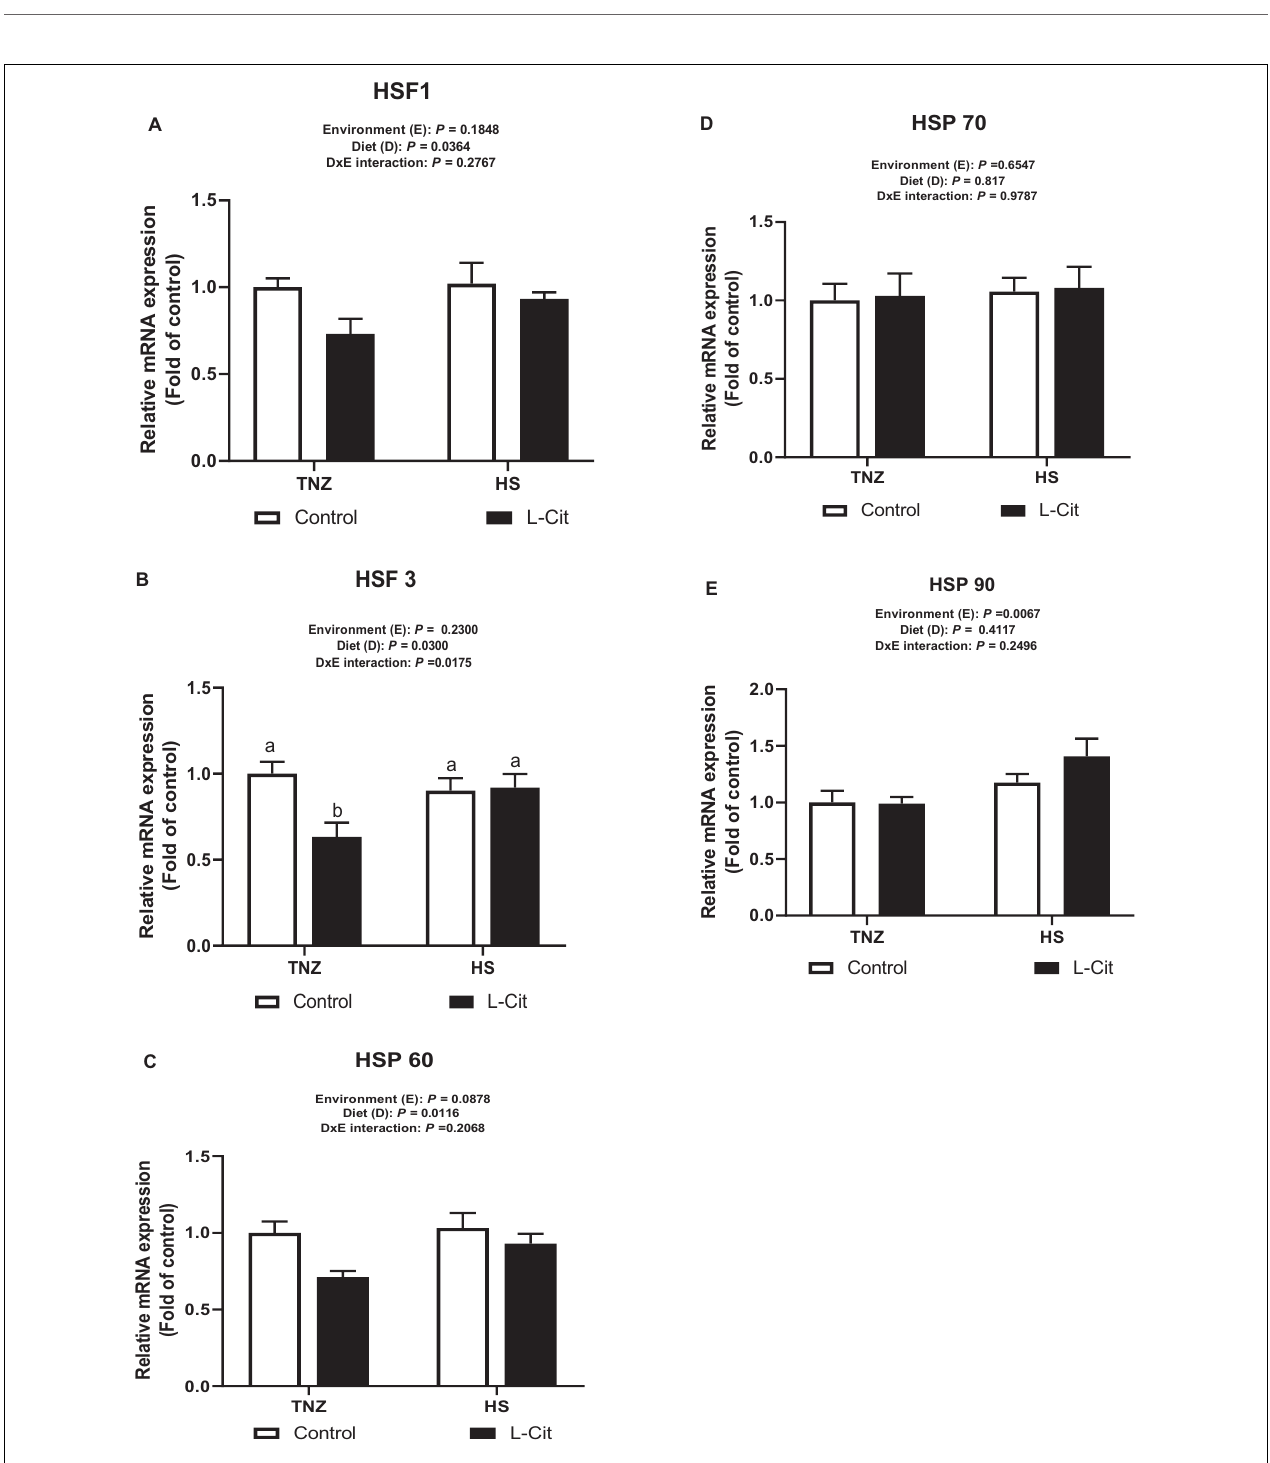
FIGURE 4 | Effect of L -citrulline supplementation on hypothalamic mRNA expression of stress-related genes during acute heat stress. (A) Heat shock factor 1 (HSF1). (B) Heat shock factor 3 (HSF3). (C) Heat shock protein 60 (HSP 60). (D) Heat shock protein 70 (HSP 70). (E) Heat shock protein 90 (HSP 70). Data are presented as mean ± SEM ( n = 8). TNZ, thermoneutral; HS, heat stress. a , b Different letters indicate significant difference of D × E interaction at P < 0.05.